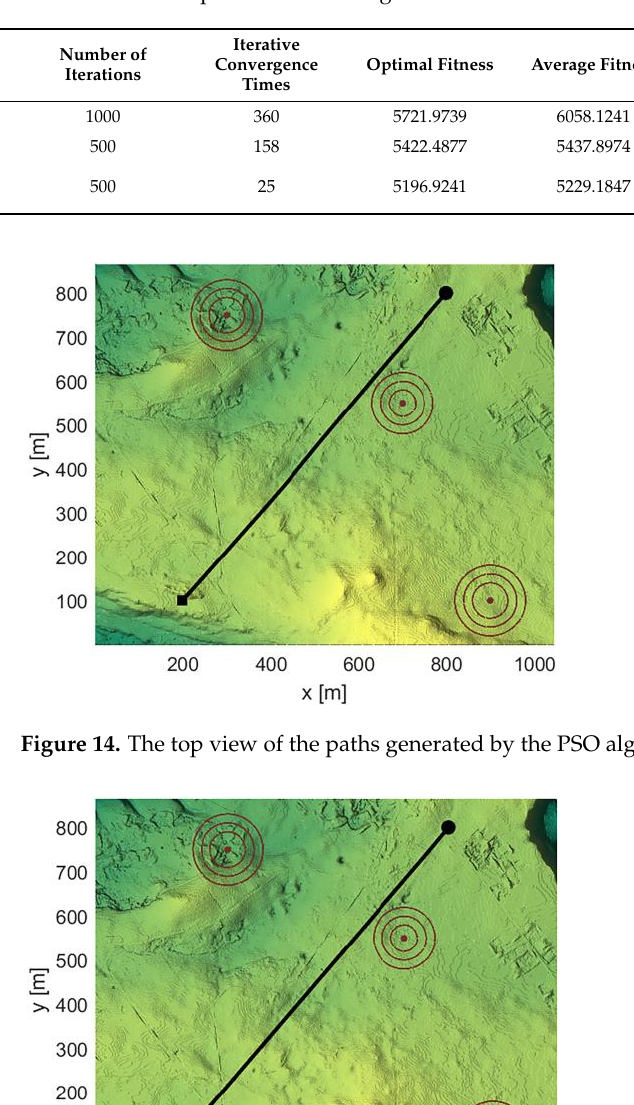
Table 7. Data comparison of three algorithms with five threats.